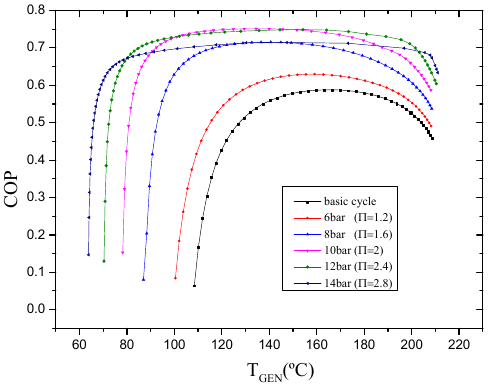
Figure 10. COP versus T GEN for configuration 1 at different intermediate pressures.